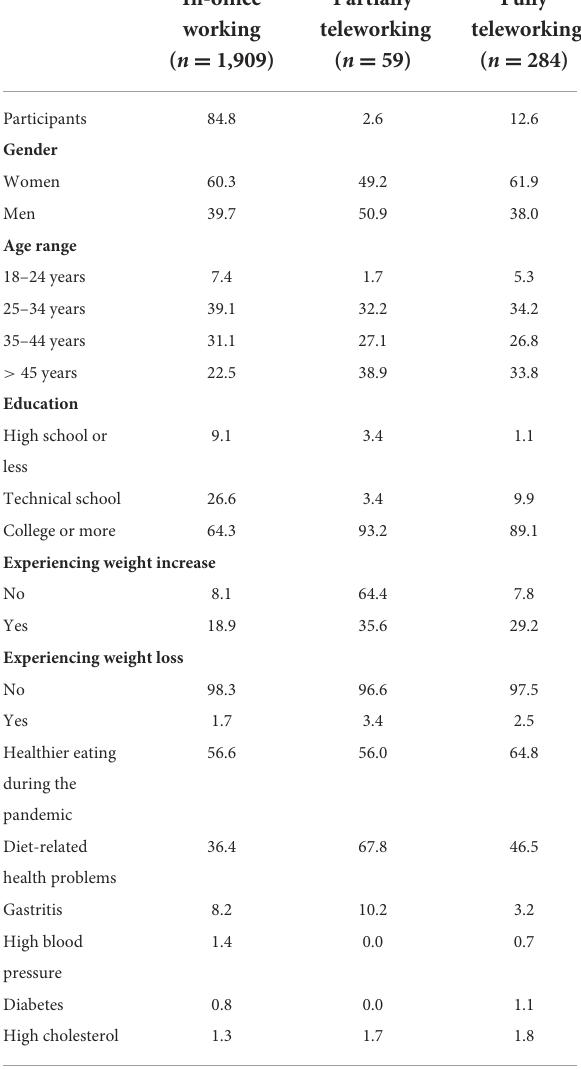
TABLE 1 Descriptive statistics of the